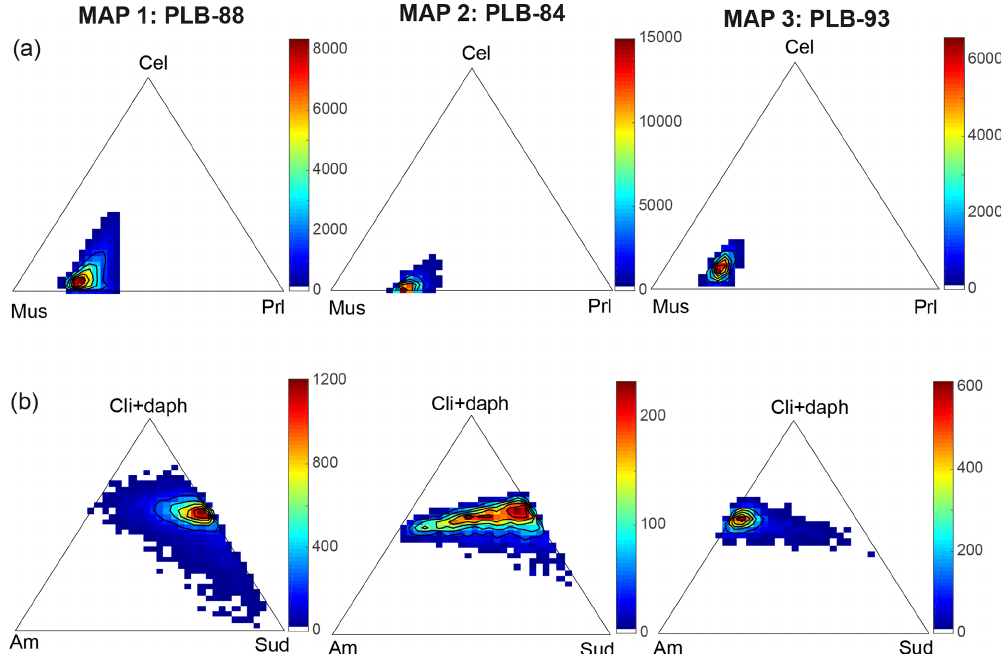
Figure 5. Ternary plots of all the analyzed white micas (a) (Cel: celadonite, Mus: muscovite, Prl: pyrophyllite) and chlorite (b) (Cli + Daph: clinochlore + daphnite, Am: amesite, Sud: sudoite) plotted with the XMapTools TriPlot3D module. Color bars refer to the number of mica– chlorite pixels analyzed.